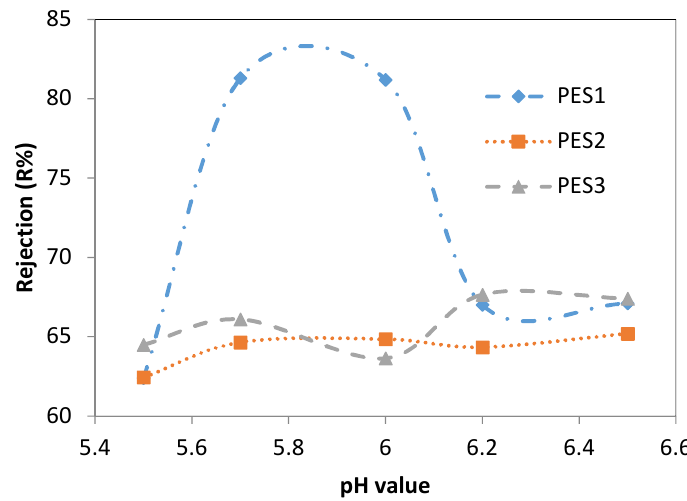
Figure 5. E ff ect of feed pH value on pb 2 + rejection of PES1, PES2, and PES3 membranes (experimental Membranes 2020 , 10 , x FOR PEER REVIEW conditions: pb 2 + concentration of 100 ppm, transmembrane pressure of 1 bar). Figure 5. Effect of feed pH value on pb 2+ rejection of PES1, PES2, and PES3 membranes (experimental conditions: pb 2+ concentration of 100 ppm, transmembrane pressure of 1 bar).